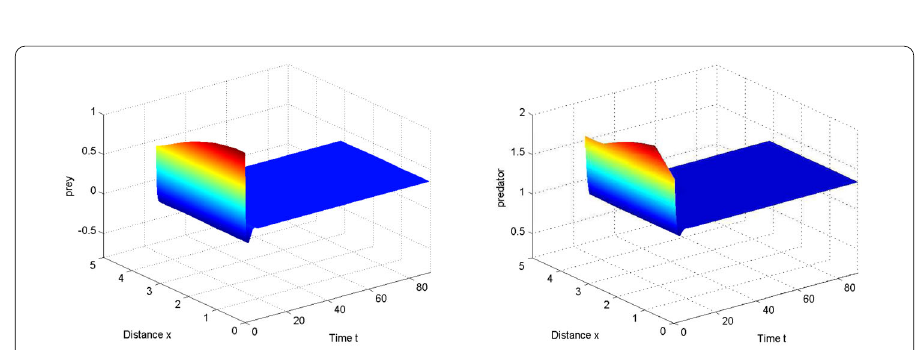
Figure 7 The bifurcation solution (cid:13) 3 ( h ) is stable for χ 3 = –0.6104, K 2 ≈ –2.3938 <